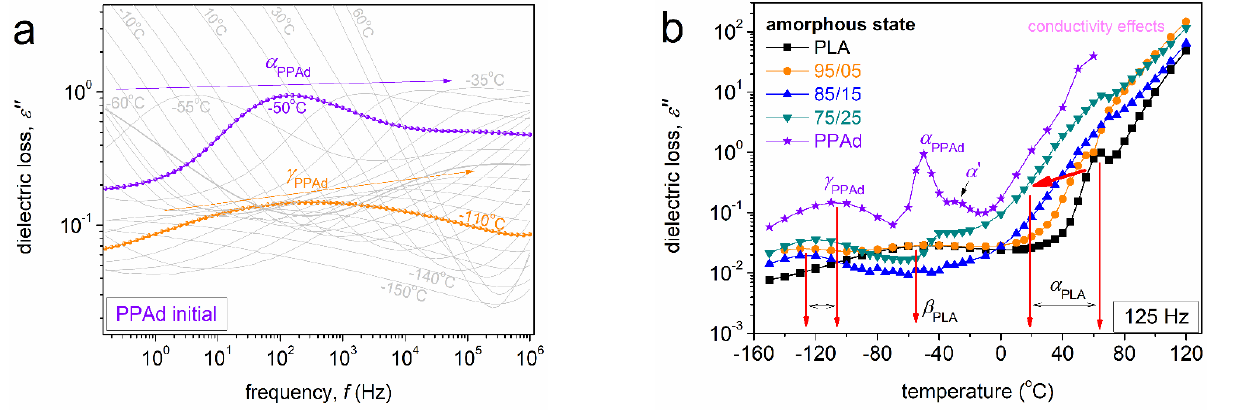
Figure 9. ( a ) Raw BDS spectra in terms of isothermal ε (cid:48)(cid:48) ( f ) curves shown at the example of initial PPAd. ( b ) Comparative isochronal curves of ε (cid:48)(cid:48) against temperature for all samples, upon replotting from the raw isothermal curves, for the initial amorphous state. The results in ( b ) correspond to the representative frequency of 125 Hz. The main recorded relaxation mechanisms, recorded as peaks of ε (cid:48)(cid:48) , are indicated on the plots. The added red arrow in ( b ) marks the effect on the main relaxation imposed by the increase of the PPAd